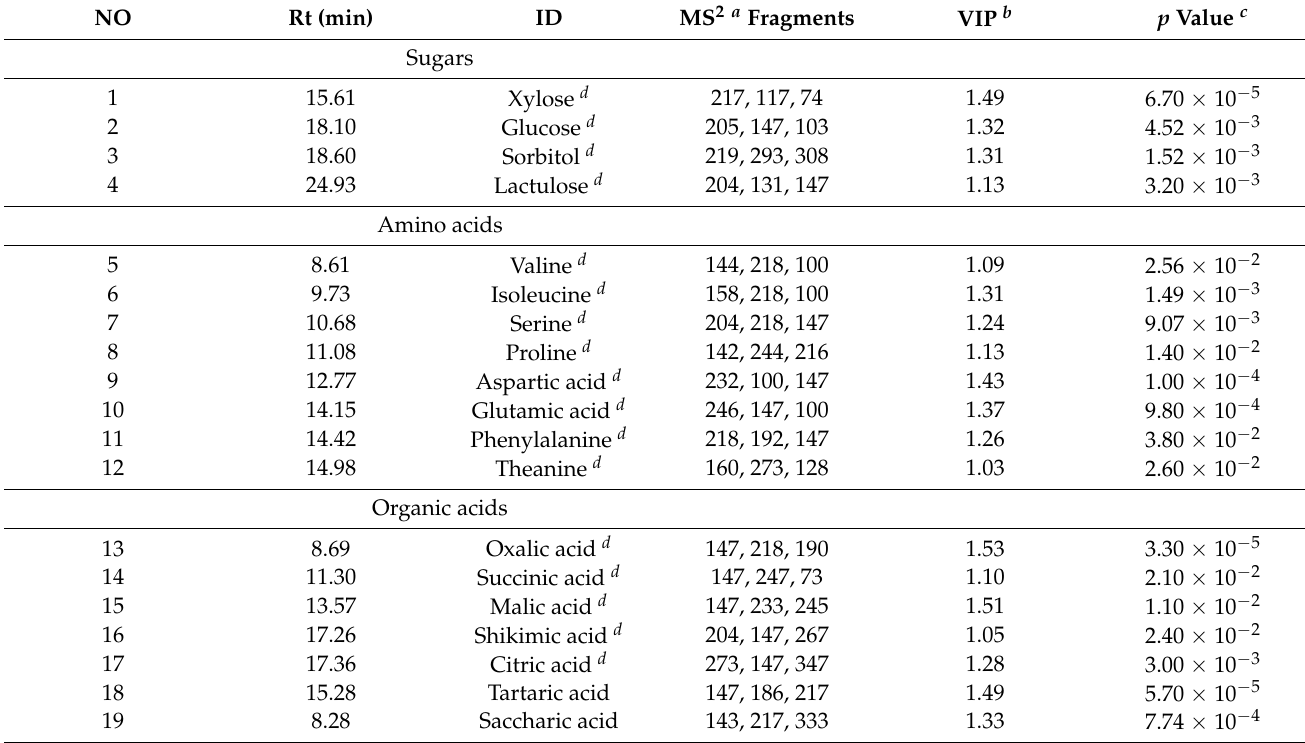
Table 3. Statistically important metabolites in tea samples derived from GC-TOF MS analysis.